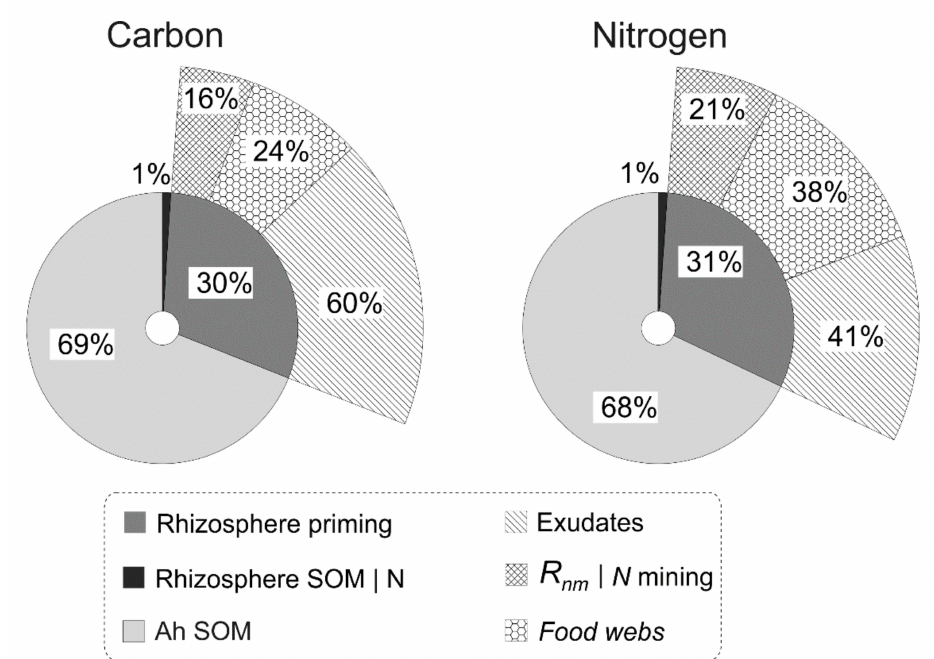
Figure 7. Simulated carbon (C) and nitrogen (N) fluxes in the forest soil (Ah horizon, pools of soil C and N are 6.91 and 0.49 kg m − 2 , respectively) with a regular root exudates input (0.5 g [C] m − 2 day − 1 , C:N = 40) over 30 days. “Carbon” on the figure represents C-CO 2 emission at priming ( R PE , Equation (21)) plus C-CO 2 of SOM mineralisation in the rhizosphere and bulk soil. “Nitrogen” is an available nitrogen mineralized in the rhizosphere and bulk soil of the whole Ah horizon plus nitrogen from root exudates mineralisation ( N RE ), produced by N mining ( N av , Equation (22)) and obtained from faunal by-products. The sum of C and N fluxes (data used in circle diagrams) is 53.8 and 2.99 g m − 2 month − 1 ,